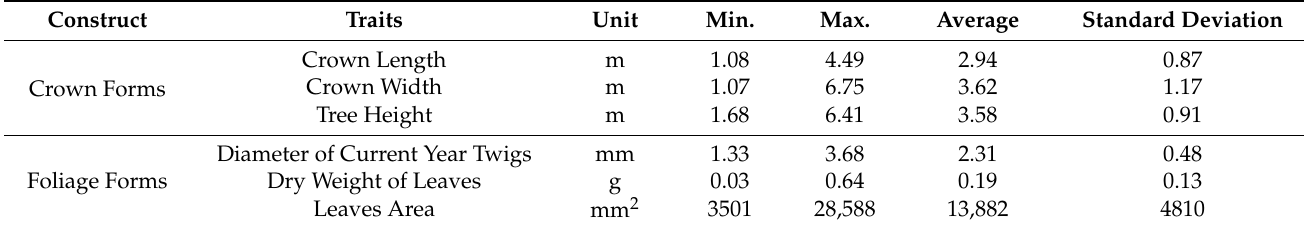
Table 2. Descriptive statistics of visual form traits ( n = 218).